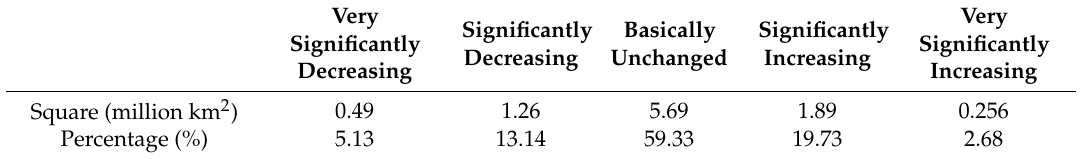
Figure 10. Annual average LST changes from 2003 to 2018. Table 4. Statistics of annual average LST of different variation levels.